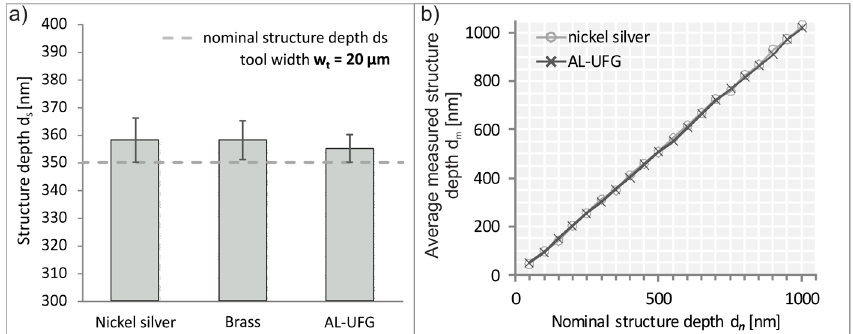
Figure 9. ( a ) Measured structure depth and ( b ) average deviation of the measured structure depth with respect to the nominal structure depth.